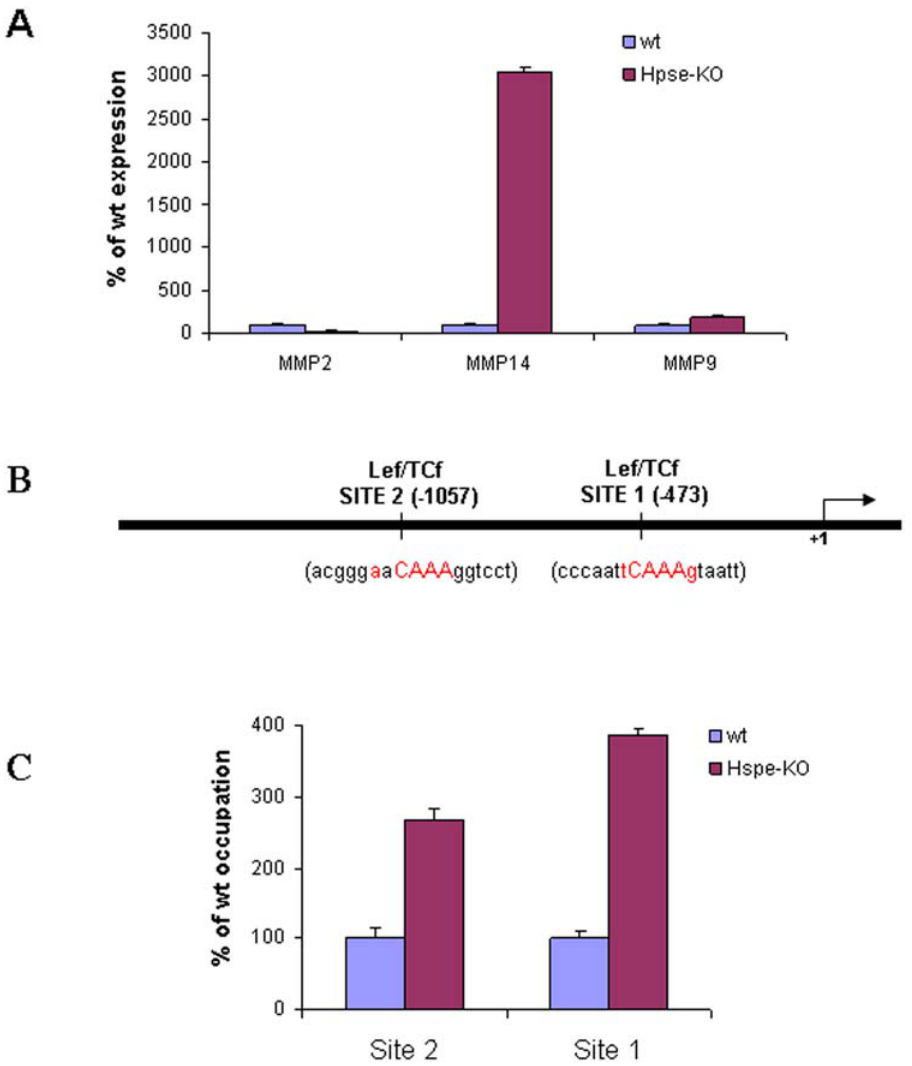
Figure 7. MMP expression and ChIP analysis for b -catenin in MEF cells derived from Hpse- KO and wt mice. A. Real-time PCR. RNA was extracted from MEF derived from wt and Hpse- KO mice and subjected to quantitative real time PCR analysis to evaluate the expression of MMP-2, MMP-9, and MMP-14. The expression level determined for each MMP in the wt tissue (blue) was regarded as 100% and the corresponding levels determined in the Hpse- KO cells (purple) are presented as percentage relative to it. Each reaction was repeated 6 times and the mean 6 SD is indicated. B. Schematic representation of regions along the murine MMP-14 promoter with $ 95% homology to the consensus Lef/Tcf motif. Numbers show the location of putative Lef/Tcf motifs relative to the transcription initiation site ( bent arrow ). C. ChIP analysis. Following cross-linking of proteins to DNA, chromatin derived from Hpse- KO and wt MEF was sonicated into fragments of average length # 500 bp; the b -catenin protein was immunoprecipitated with anti b -catenin antibody, and PCR analysis was performed on the immunoprecipitated DNA samples using primer sets MMP14-Pro1 & Pro2, as described in ‘Materials and Methods’. Samples were equilibrated for DNA loading amounts using primers specific to actin. The results are representative of three independent